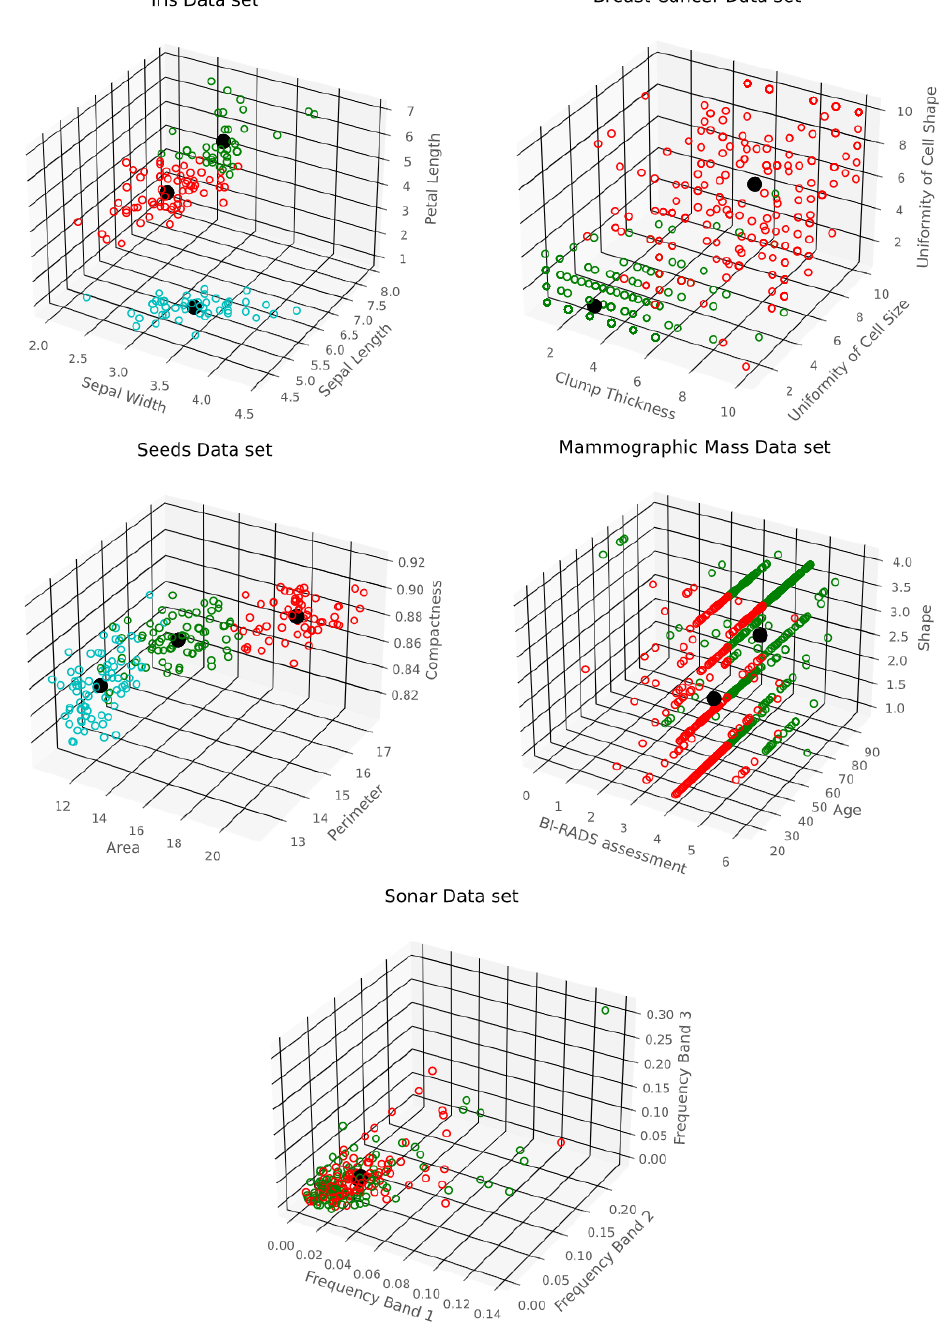
Figure 11. Visualization of the cluster centers using K-Means on experimental data sets.